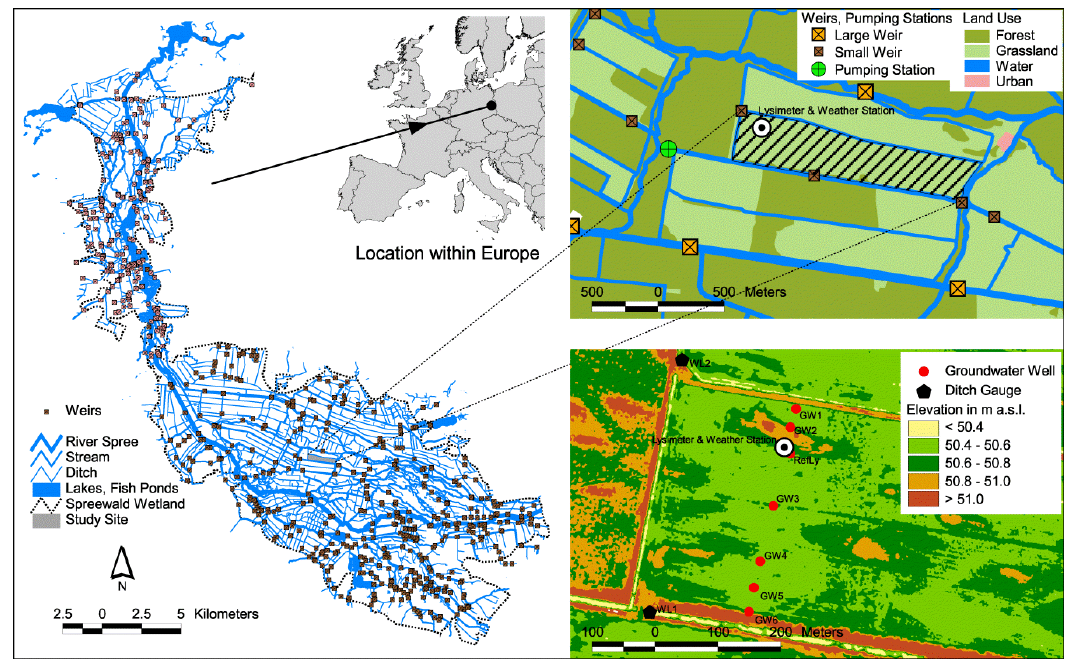
Figure 1. Map of the stream network of the Spreewald wetland with weirs ( left ), study site with ditches, small weirs and land use types ( top right ) and surface elevation of the study site with monitoring system consisting of groundwater observation wells, ditch gauges, lysimeter and weather station ( bottom right ).